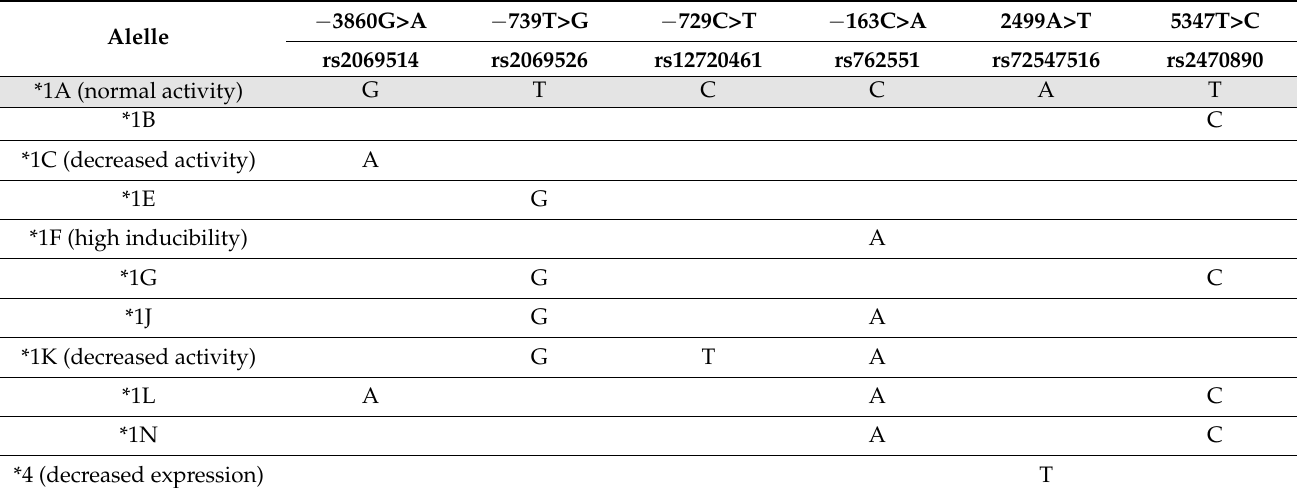
Table 1. Allele definition table for CYP1A2